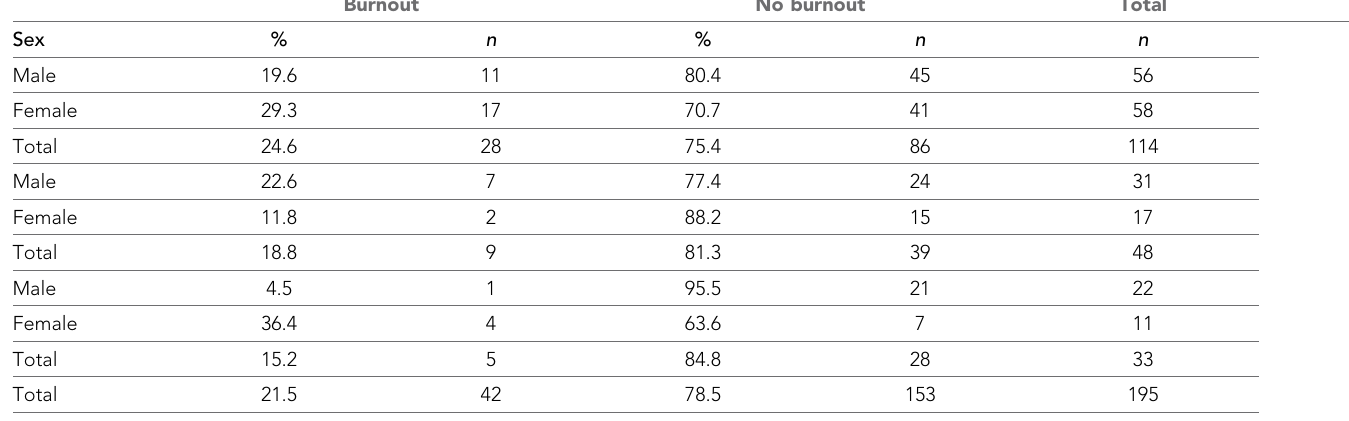
Table 1. The relation between burnout, work engagement, and norms and values: are there intergenerational differences?